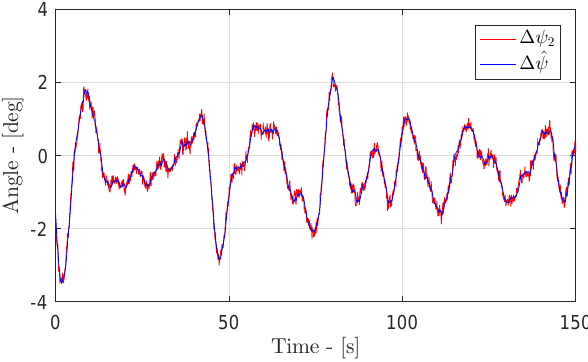
Figure 19: Sensor fusion performance in z-direction.